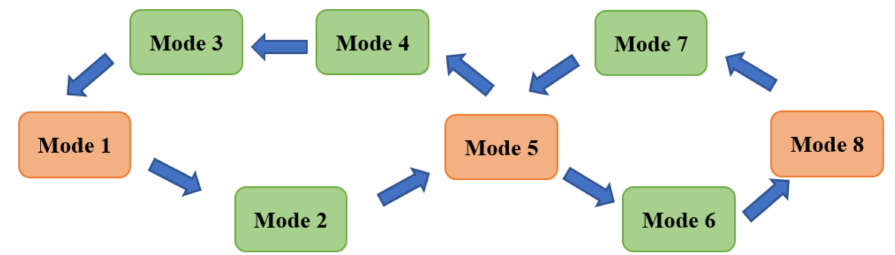
Figure 6. HEV’s operation-mode-switching diagram.